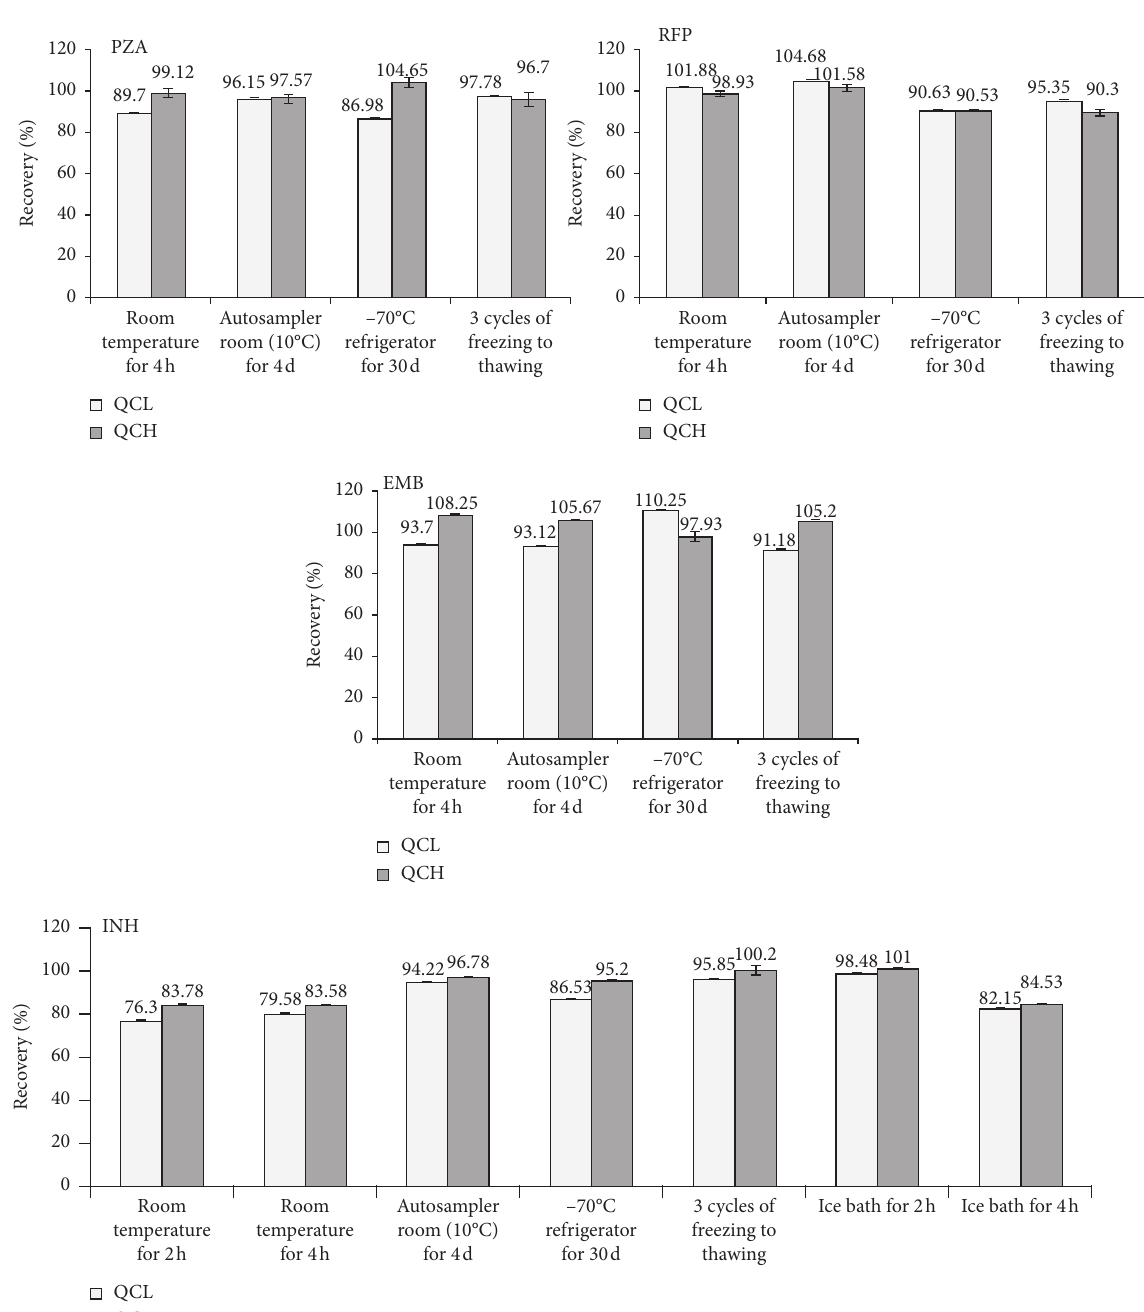
Figure 3: Stability of four analytes in QC samples of two levels after storing in several conditions ( n �